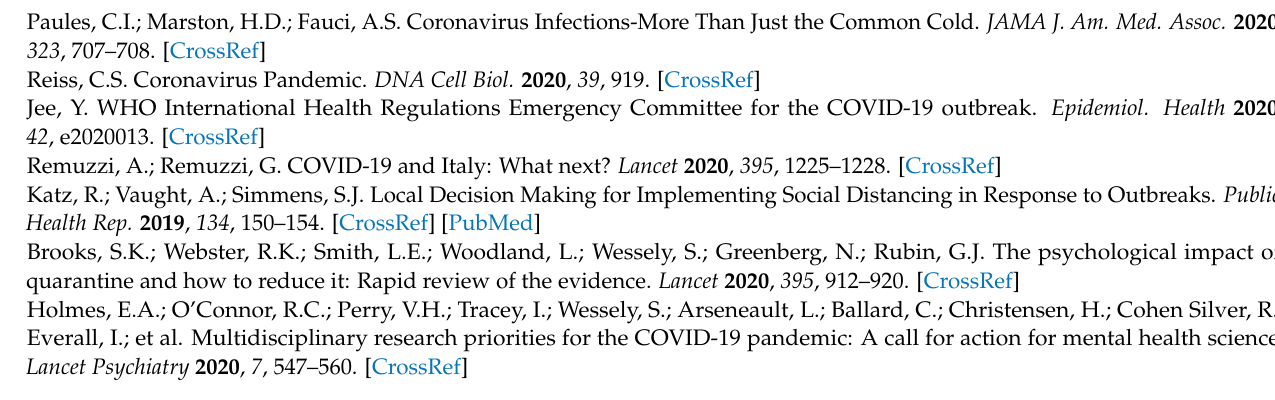
to real values; Table S1: Estimated parameters for Linear Mixed Models fitted for primary outcome measures; Table S2: Estimated parameters for Linear Mixed Models fitted for state outcome measures; Table S3: Bonferroni adjusted-pairwise comparisons for all primary and secondary outcome measure across the different time